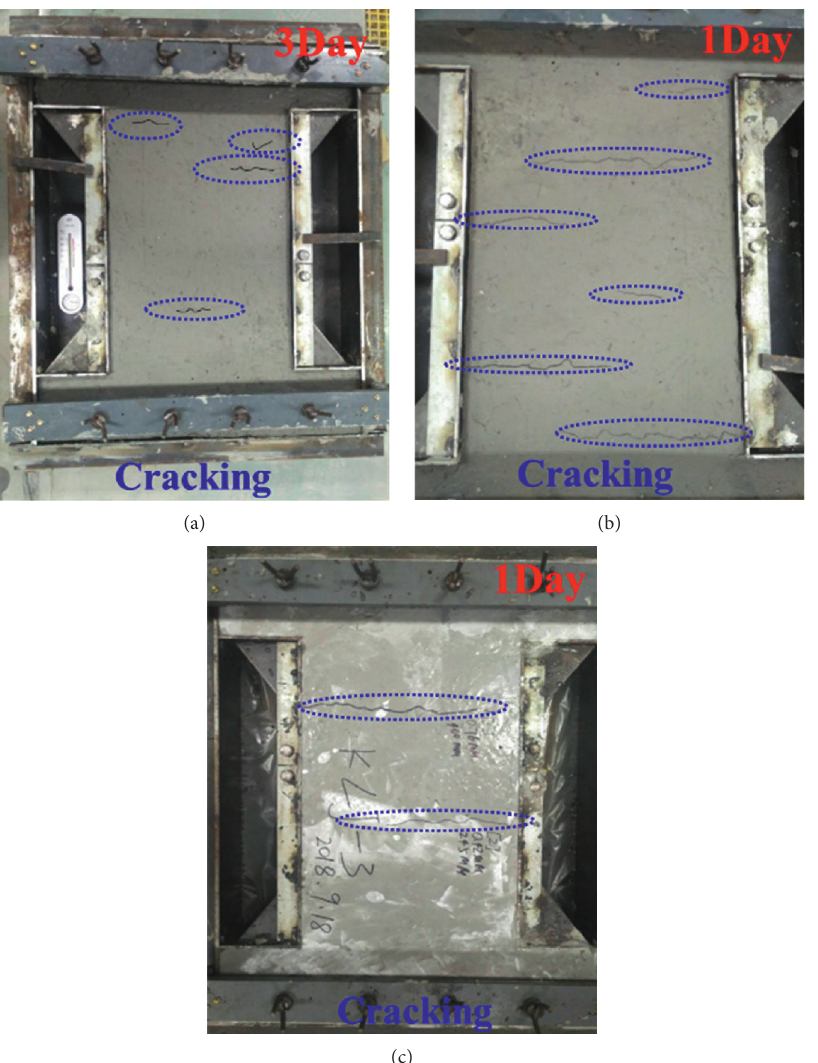
Figure 10: The cracking state of the concrete in the slab cracking frame. (a) TS-1 concrete; (b) TS-2 concrete; (c) TS-3